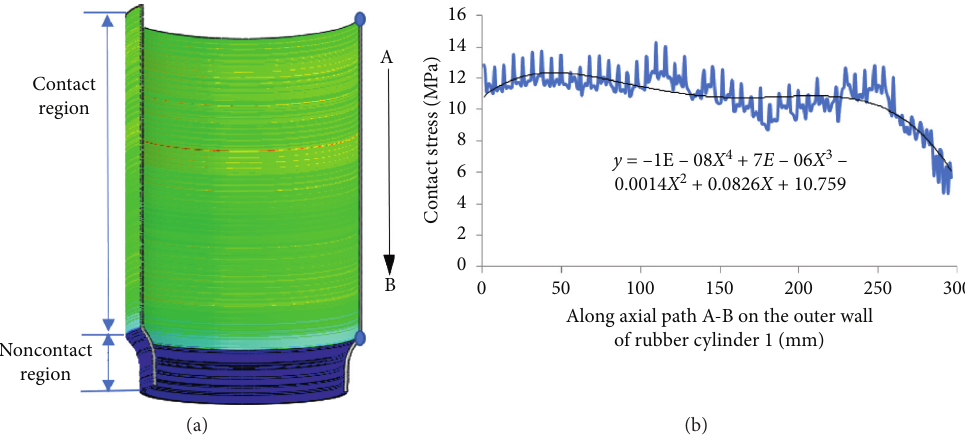
Figure 11: Contact stress variation in the rubber cylinder 1 and the average contact stress along the axial path on the outer wall of the rubber cylinder during the expansion.